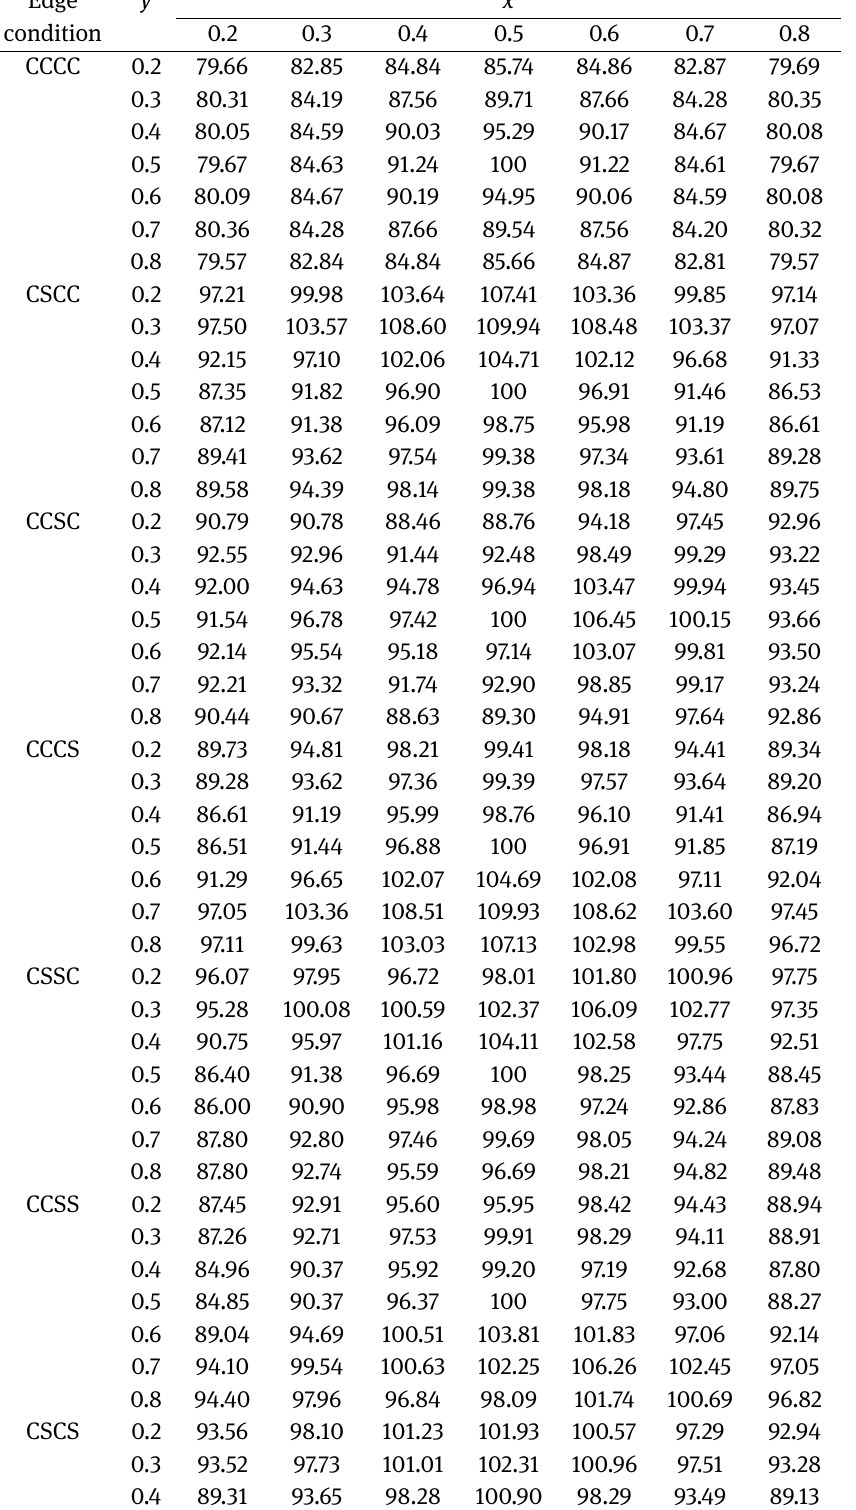
Table 8: Values of ‘ r ’ for + 45/-45/ + 45/-45 elliptic parabolic shells. Edge y